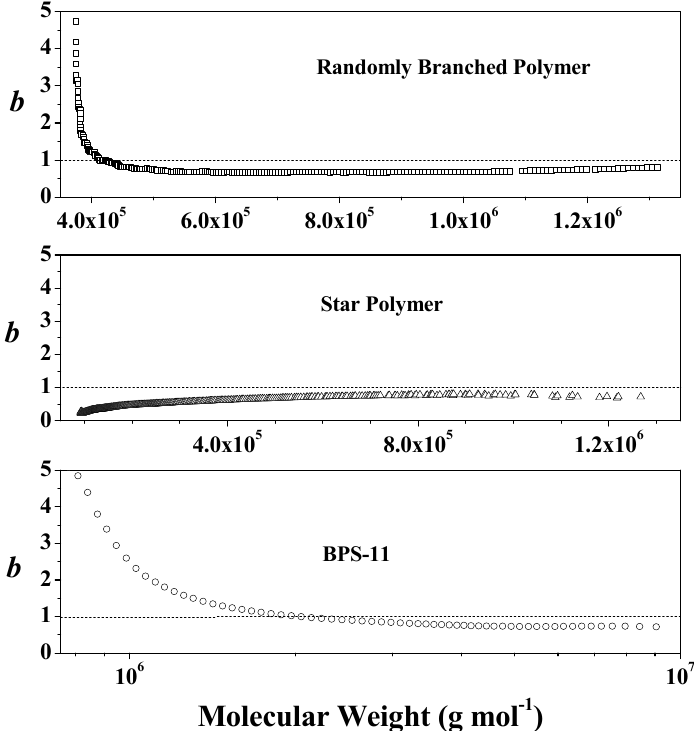
Figure 5. Changes in the exponent b with molecular weight for branched polymers.